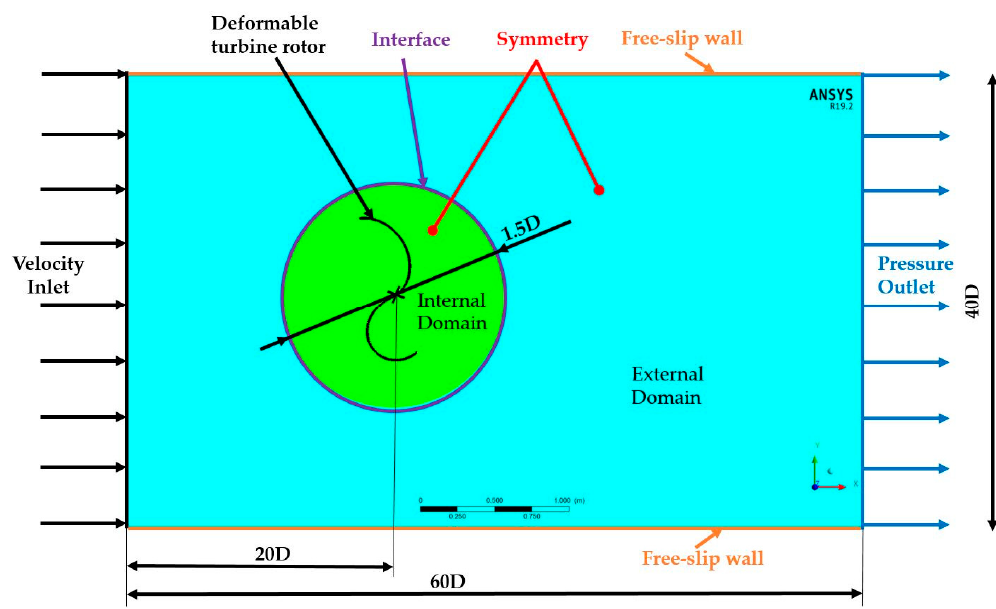
Figure 2. Computational domain scheme (external domain dimensions do not correspond to the scale).